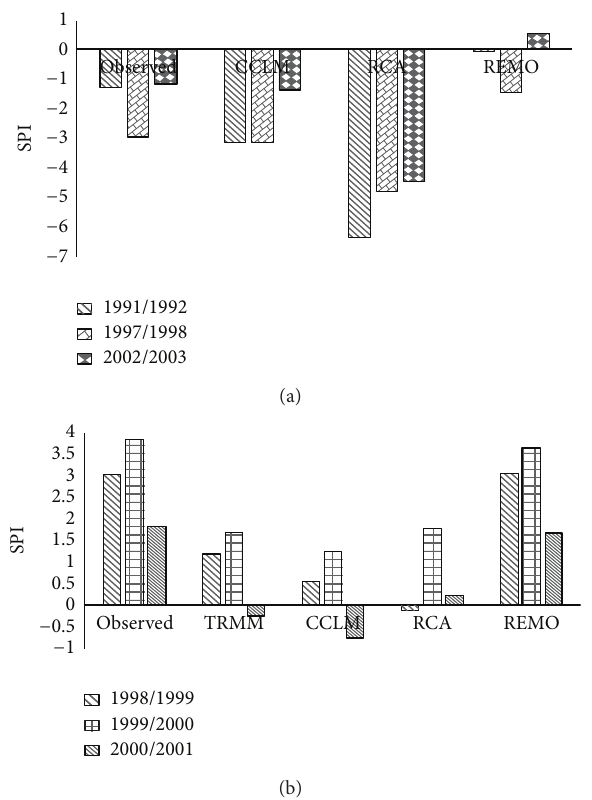
Figure 9: Standardized Precipitation Index for JJA associated with (a) El Nino events (using data for 1991/1992, 1997/1998, and 2002/2003) and (b) La Nina events (using data for 1998/1999, 1999/2000, and 2000/2001) as simulated by CORDEX RCMs, com- pared against the ground observation data and TRMM observation (TRMM excluded for El Nino because of data